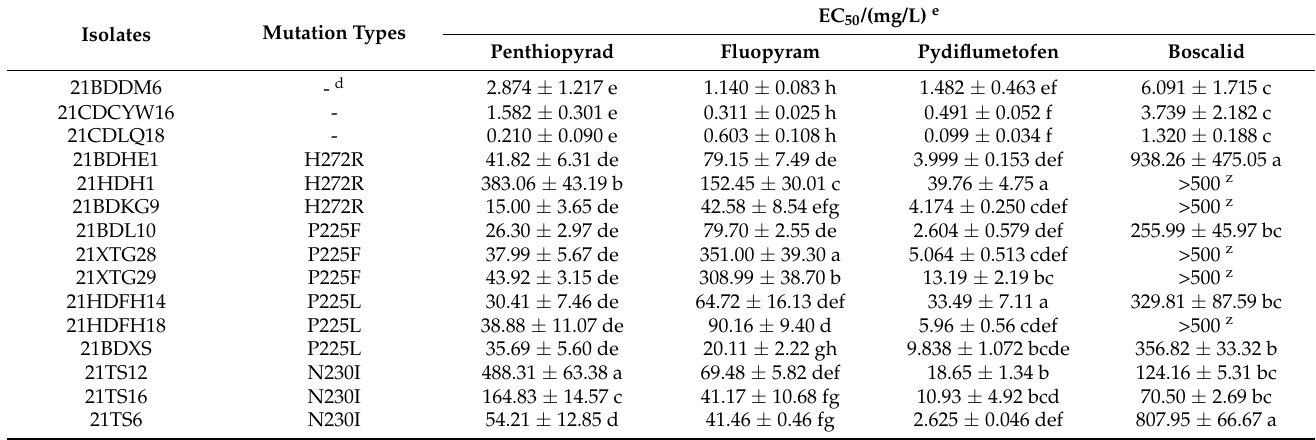
Table 5. The EC 50 values of four SDHI fungicides against three B. cinerea isolates with no mutation and 12 isolates with four different mutations (H272R, P225F, P225L and N230I) of the gene sdhB .